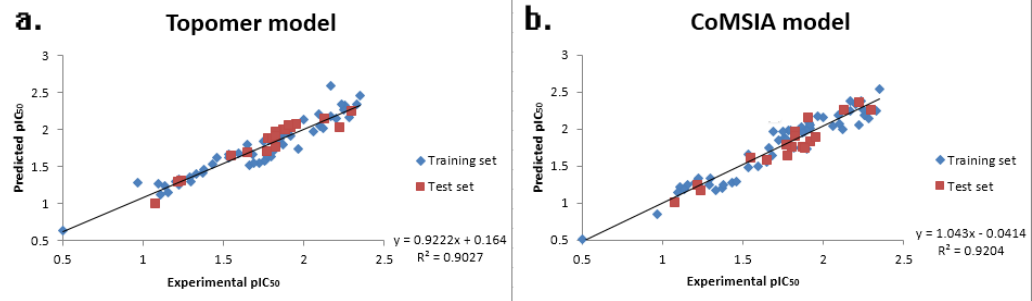
Figure 2. The experimental pIC 50 values and predicted pIC 50 values of the topomer CoMFA model ( a ) and the CoMSIA model ( b